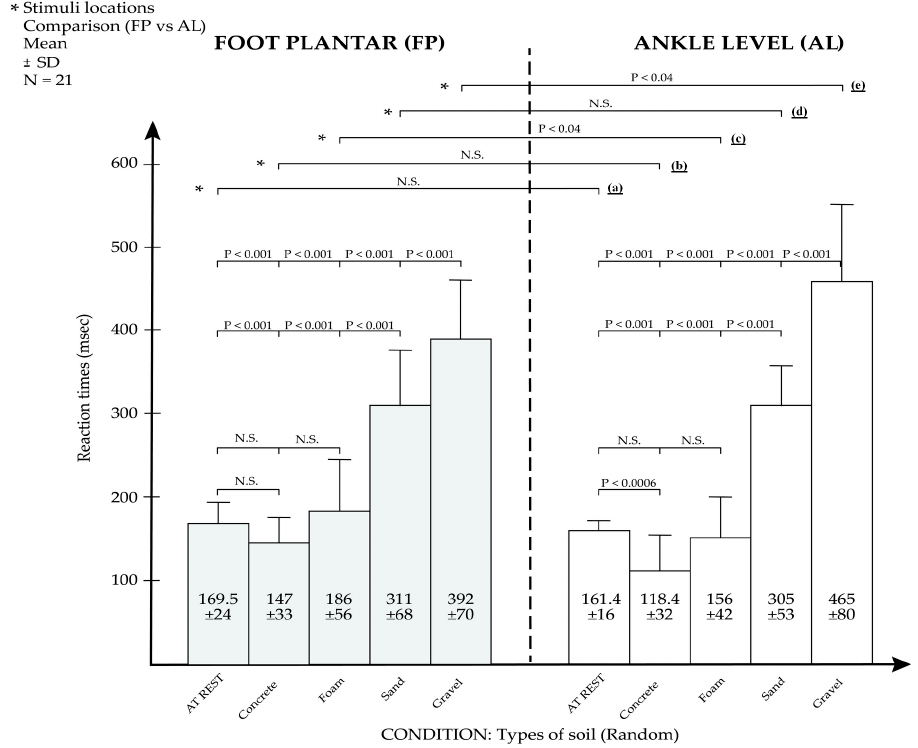
Figure 6. Comparison of reaction times on young participants at two location of stimulus (Foot plantar and Ankle). * are results from turkey comparison for the two-way ANOVA.